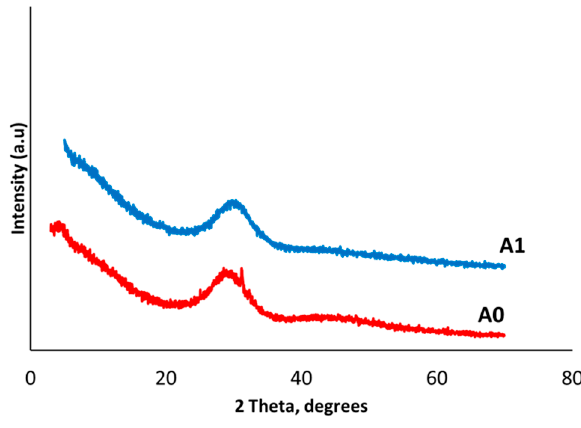
Figure 1. XRD graph of bioactive glasses A0 and A1.